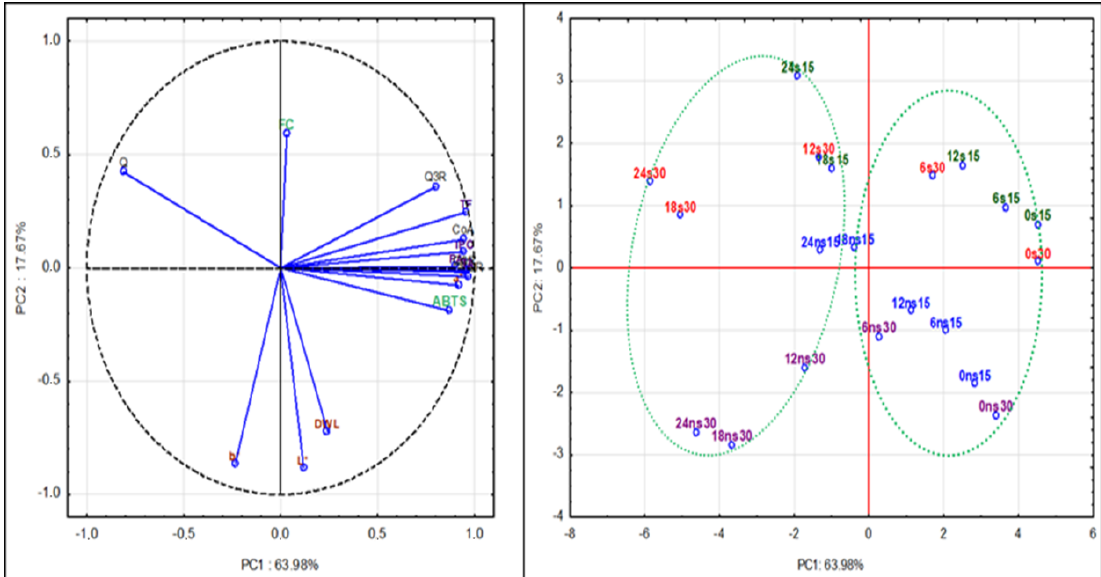
Figure 2. Principal Component Analysis (PCA) loadings plot and score plot of major components, color attributes and antioxidant activity of cherry liqueurs with (s) and without sugar (ns) stored at 15 °C (15) and 30 °C (30) during 24 weeks (0, 6, 12, 18, 24).